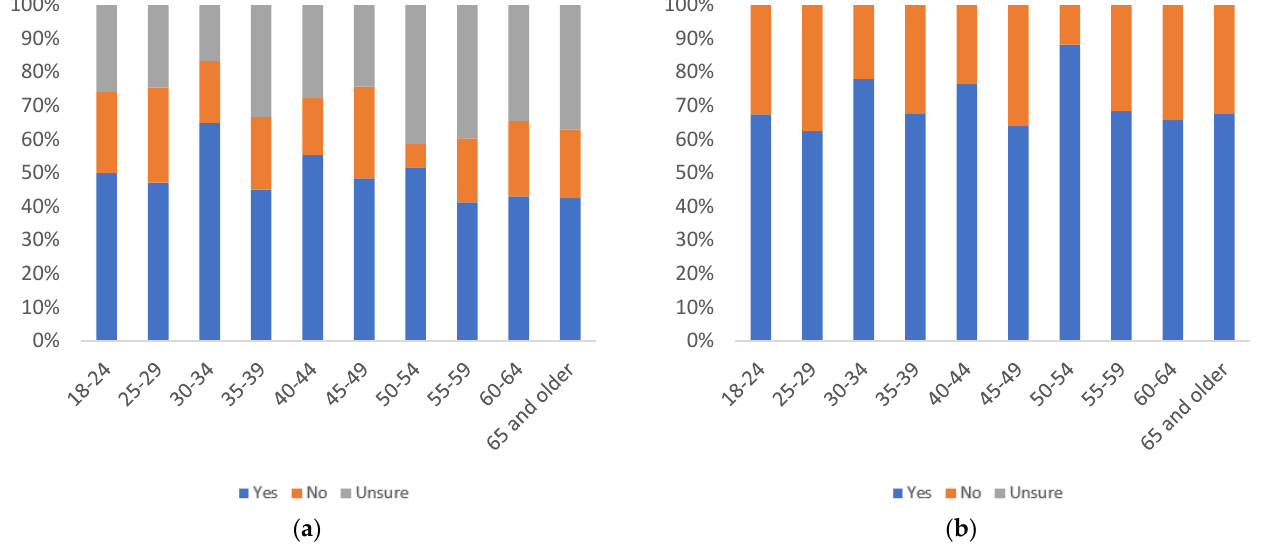
Figure 30. Label others’ use, by age group: ( a ) with uncertain respondents (left) and ( b ) without uncertain respondents (right).